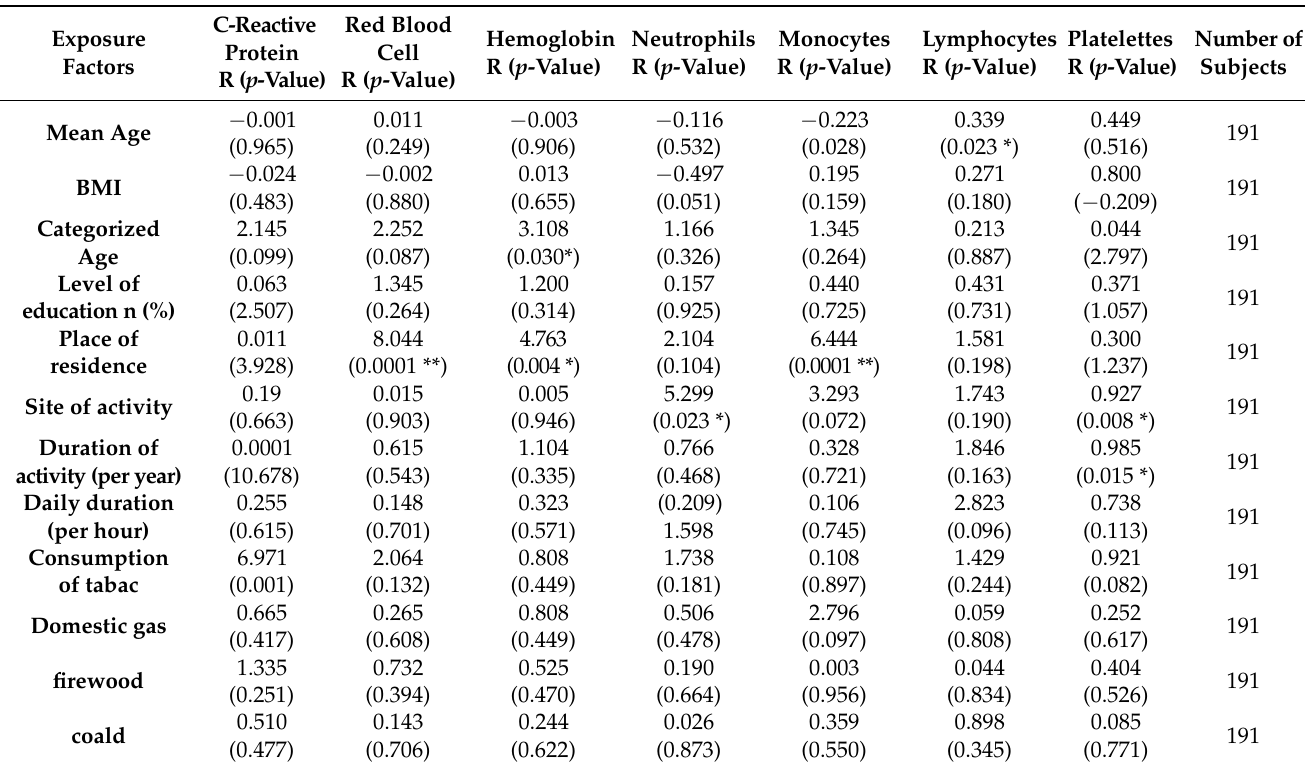
Table 7. Influence of exposure factors on the changes of some blood markers after adjustment for for age, level of education, body mass index (BMI), smoking and use of domestic gas, firewood and coal.